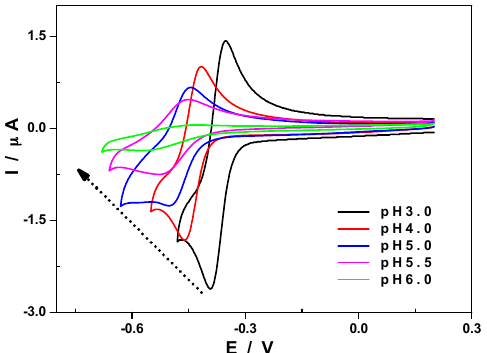
Figure 3. CVs of 1 at different pH values from 3 to 6. Polyoxometalate concentration: 0.5 mM; scan rate: 10 mV · s − 1 ; working electrode: glassy carbon; reference electrode: